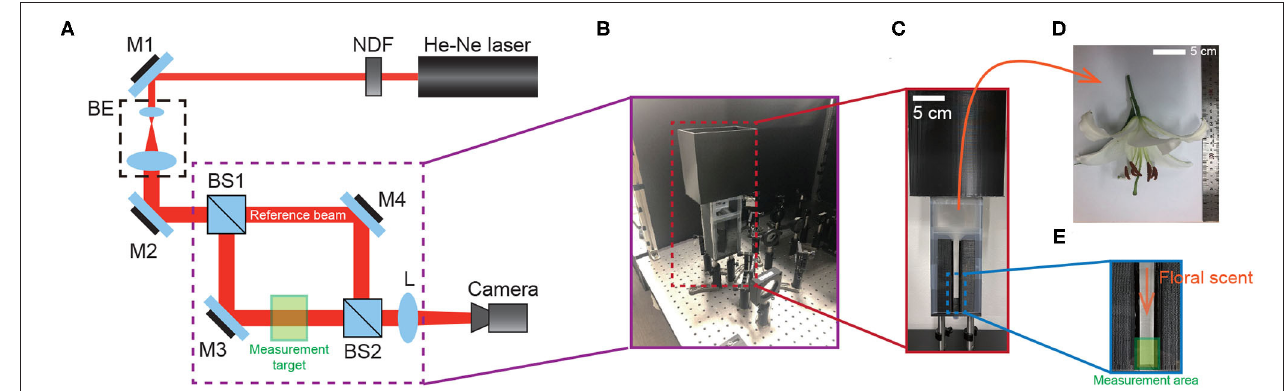
FIGURE 1 | Experimental setup. (A) Schematic of Mach-Zehnder interferometer. Red lines indicate the optical ray from He-Ne laser. NDF, neutral density filter; BE, beam expander; BS, beam splitter; M, Mirror; L, achromatic lens (f = 150 mm). Measurement target contains a flower during the measurement of floral scent. (B) Illustration for the setup for interference between a reference beam and a measurement target (C) Flower container to collect the floral scent from lily. (D) An actual flower. (E) The 2D narrow channel for the measurement